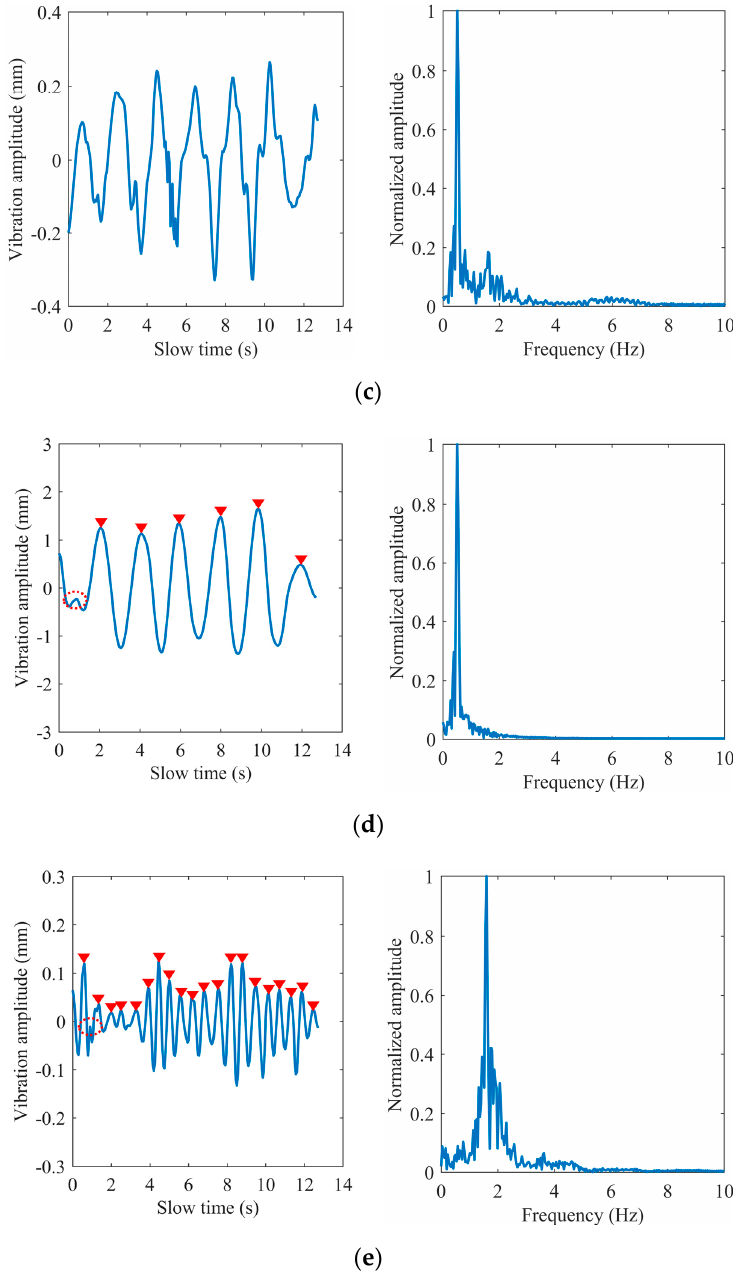
Figure 11. Subject #2: ( a ) extracted phase; ( b ) phase difference; ( c ) the impulse noise removal; ( d ) breathing waveform; ( e ) heart waveform.